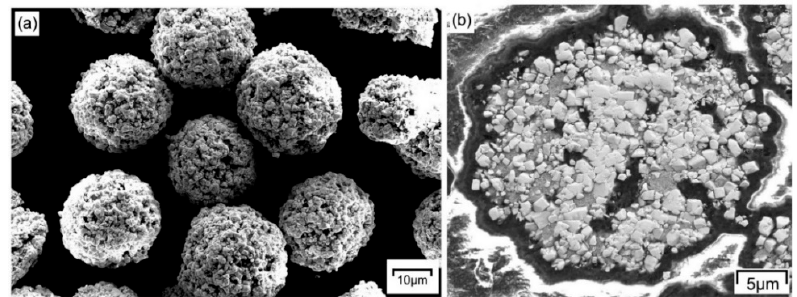
Figure 1. Surface morphology ( a ) and cross-sectional view ( b ) of the porous WC-17Co powders used in this work.